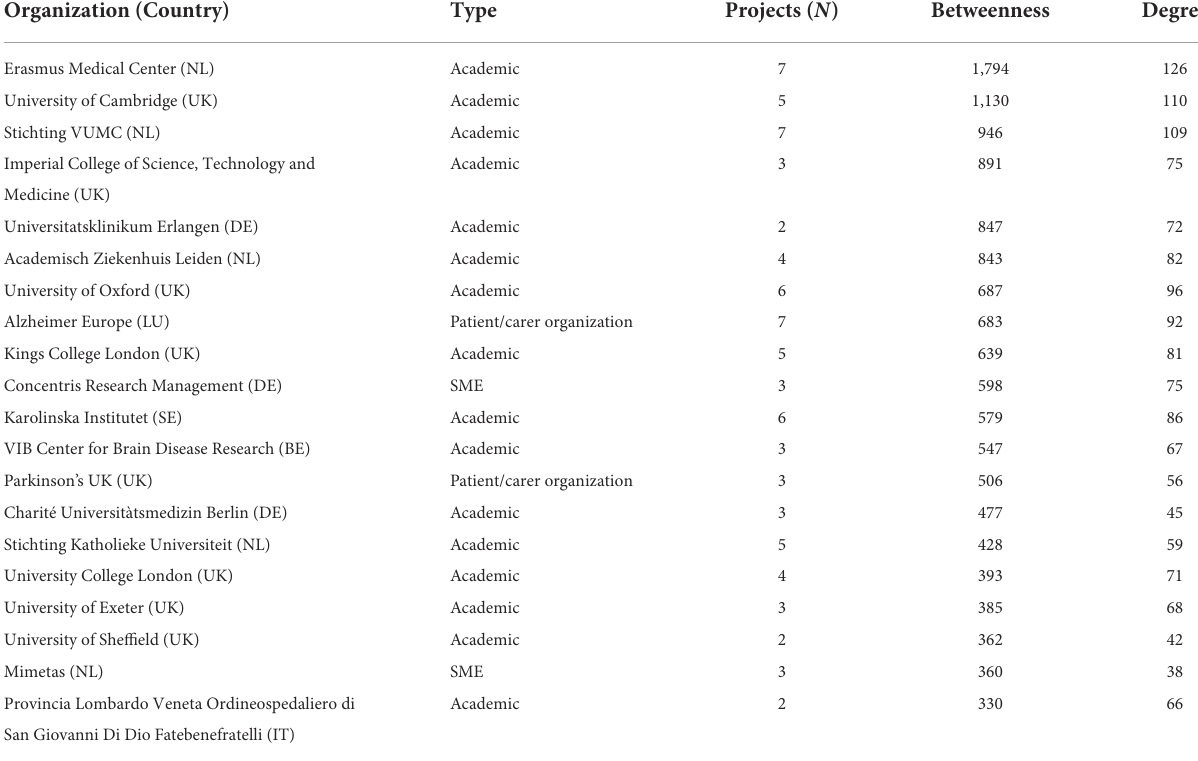
TABLE 3B Top 20 key nodes in the network analysis of the IMI NDD portfolio: Excluding EFPIA partners. Organization